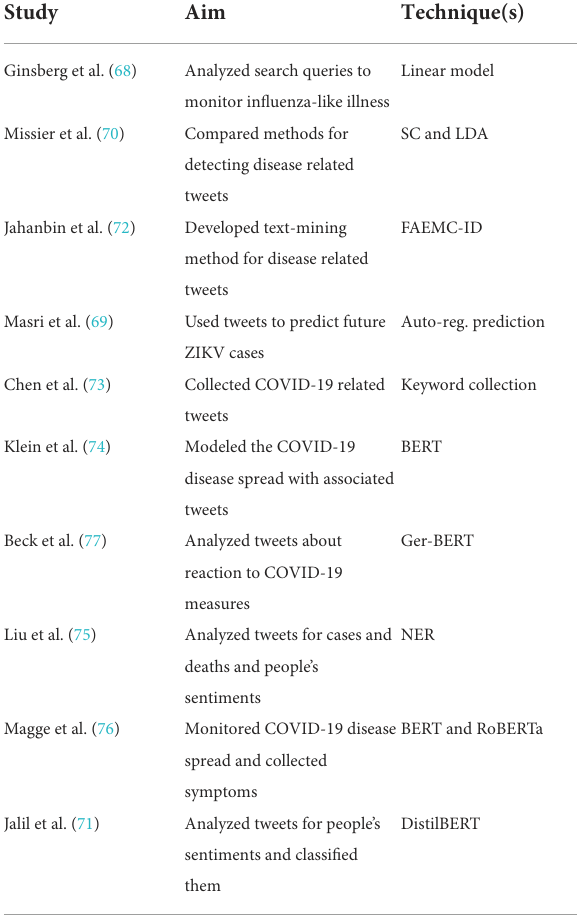
TABLE 6 Included studies focusing on disease monitoring via mining of social media and internet